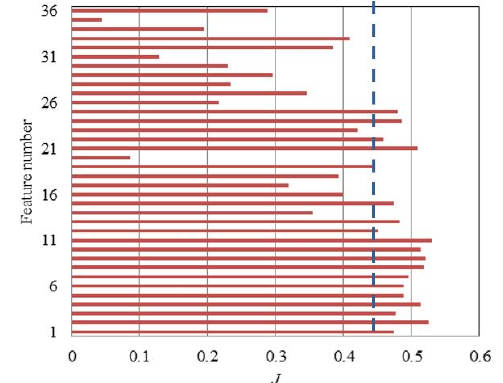
Figure 9. The comparison result: ( a ) the generator speed during whole life cycle; ( b ) PP and PP-RR.